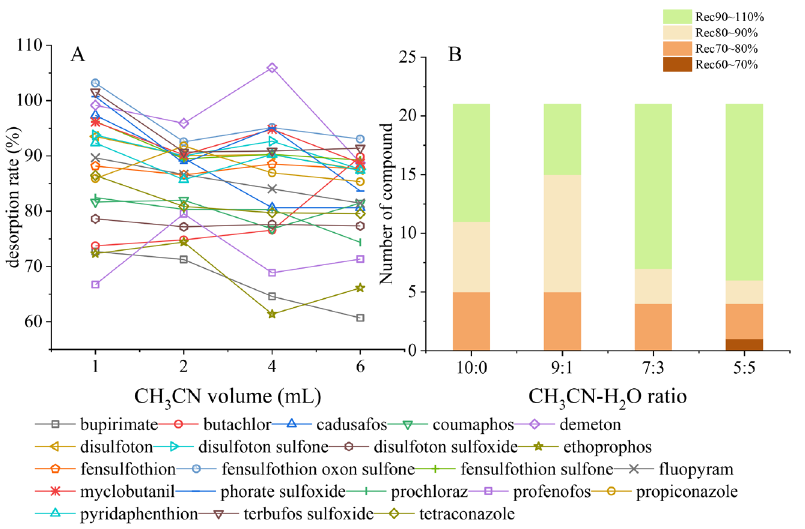
Figure 3. The desorption performance of CH 3 CN volume ( A ) and mixtures of CH 3 CN/H 2 O ( B ).